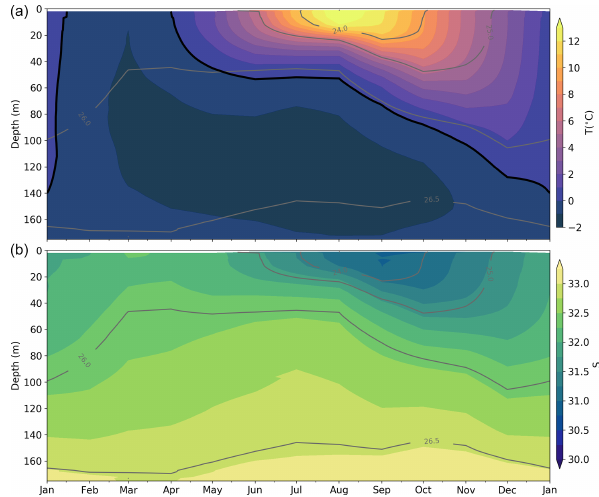
Figure 7. Climatological (1991–2020) annual cycle of tempera- ture (a) and salinity (b) at Station 27. The grey contours are the isopycnals ( σ 0 in kgm − 3 ) derived from temperature and salinity using the TEOS-10 package (McDougall and Barker, 2011). The thick black line in (a) is the 0 ◦ C isotherm delimiting the top of the CIL.